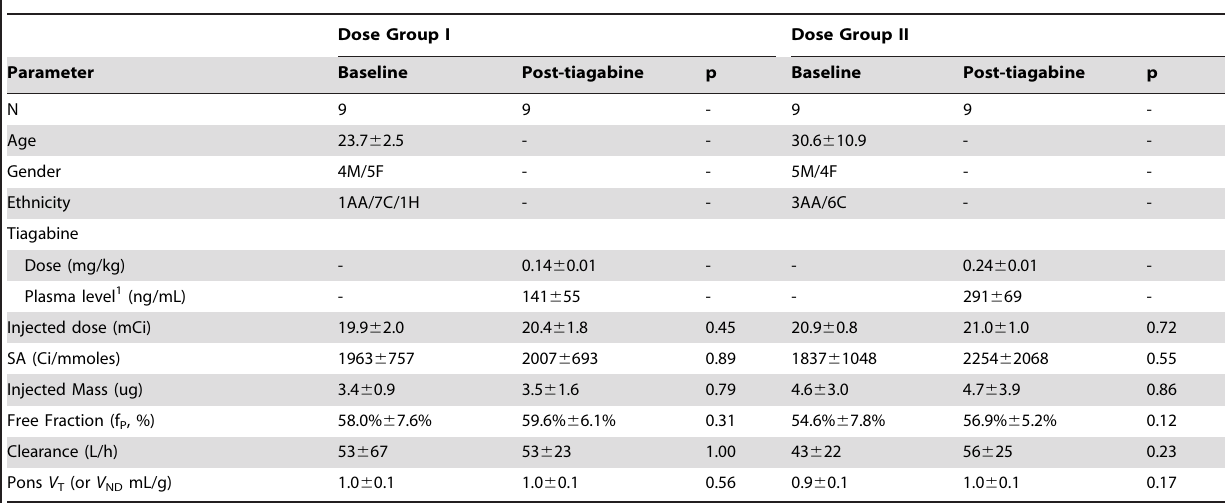
Table 1. Demographic and scan